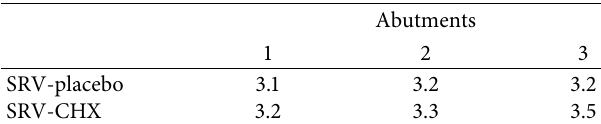
Table 2: The dry weight of coating on abutments,